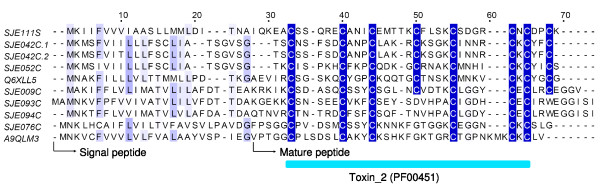
Sequence alignment of α-KTxs. SJEs are clusters from this work. The others are Q6XLL5 (alpha-KTx 6.10, Opistophthalmus carinatus), and A9QLM3 (LmKTx8, Lychas mucronatus).